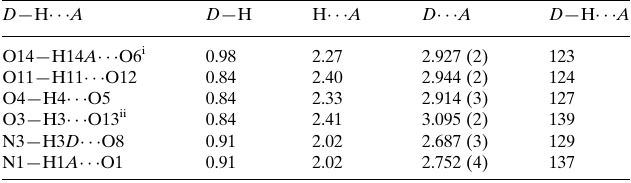
Hydrogen-bond geometry (A˚ , (cid:5)